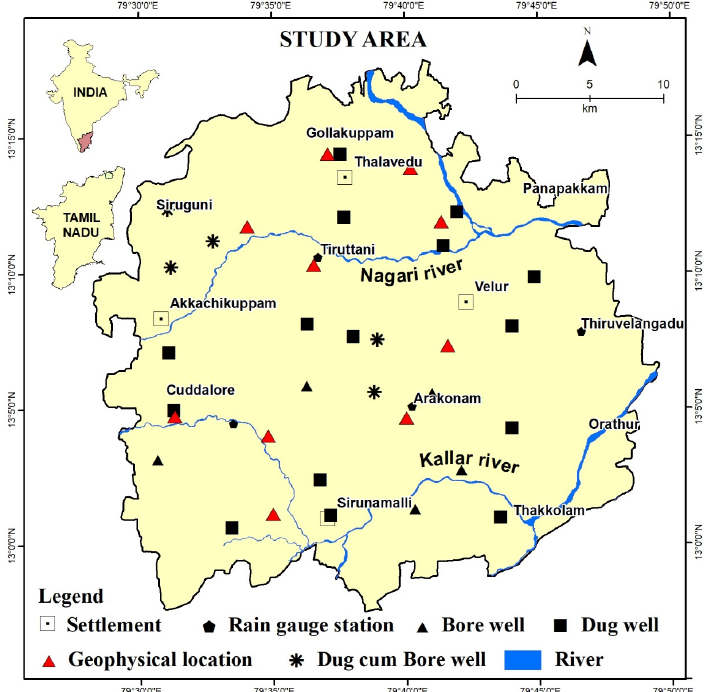
Figure 1. Map showing study area and geo-position of rain gauge stations, geophysical survey stations and pump test locations.